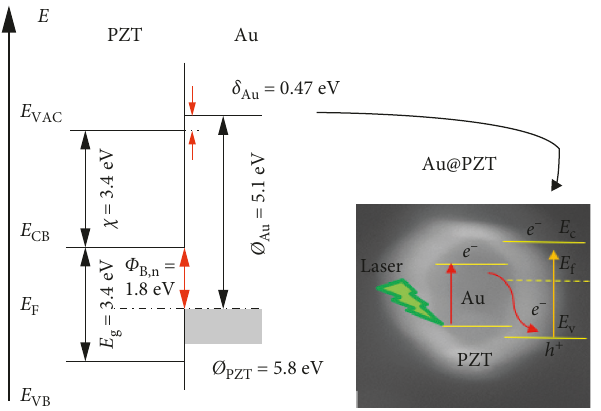
Figure 12: Band diagram of PZT/Au core/shell NP interfaces containing interface states reflected by the dipole potential δ